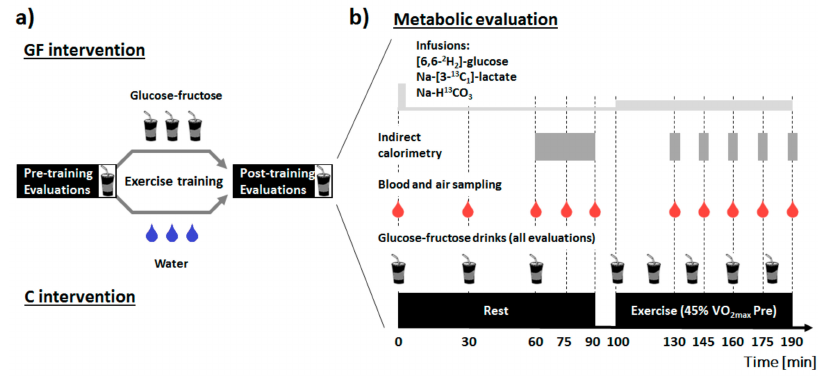
Figure 1. Study design ( a ) and description of the metabolic evaluations ( b ). Drinks containing 19 g glucose and 12 g fructose were administered at time 0, 30 and 60 min at rest, and at 20 min intervals during exercise. Primed-continuous infusions of (6,6- 2 H 2 )- D -(+)-glucose and Na-(3- 13 C 1 )- L -(+)-lactate were started at time 0, and resting measurements were obtained after 60 min equilibration. Continuous infusion rates were upgraded at the beginning of exercise at time 100 min (see methods for further details). GF: intervention in which glucose-fructose drinks were provided during training sessions; C: control intervention in which plain water was provided during training